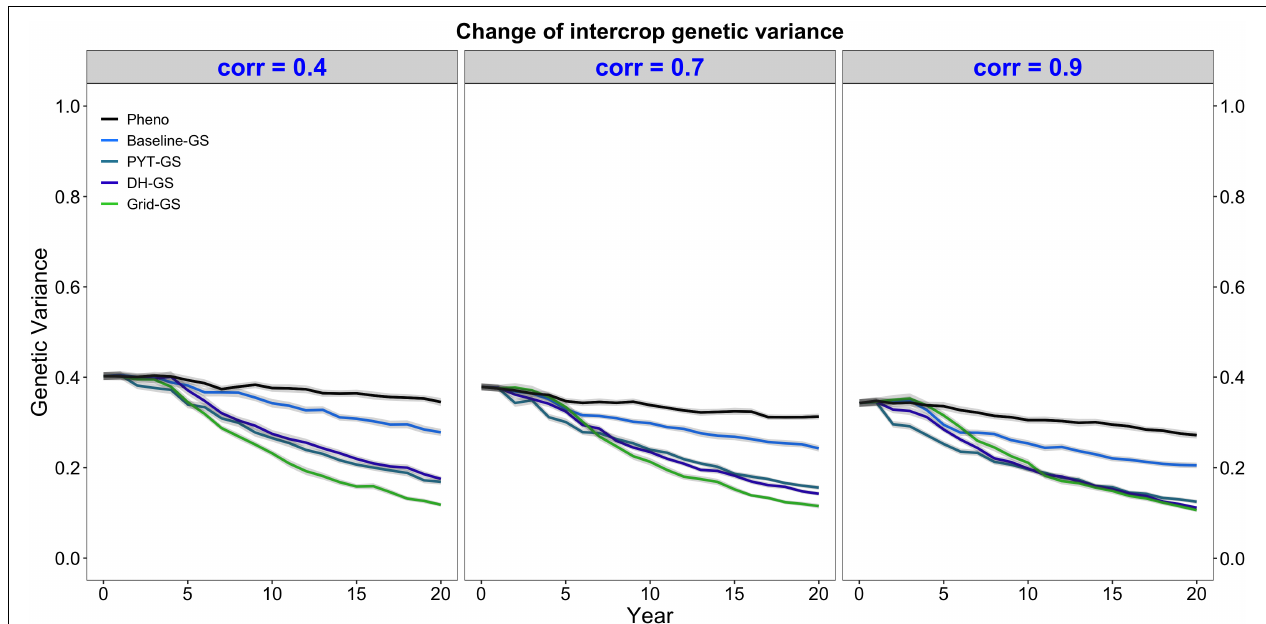
FIGURE 4 | Intercrop genetic variance over time for five simulated breeding programs. Results are shown under genetic correlations of 0.4, 0.7, and 0.9. Simulations are based on a medium annual operating budget (approx. United States $500K). Intercrop genetic variance is plotted as variance of intercrop genetic values in the doubled haploid stage for the entire future breeding phase. The lines within each of the three panels represent the five breeding programs where each line represents mean intercrop genetic variance for the 30 simulated replicates and the shadings show standard error bands. The black line represents the Phenotypic selection breeding program (Pheno), the blue-colored lines represent the three Conventional genomic selection breeding programs (Baseline-GS, the Baseline genomic selection breeding program; PYT-GS, the Preliminary yield trial genomic selection breeding program; DH-GS, the Doubled haploid genomic selection breeding program) and the green-colored line represents the Grid genomic selection breeding program (Grid-GS).